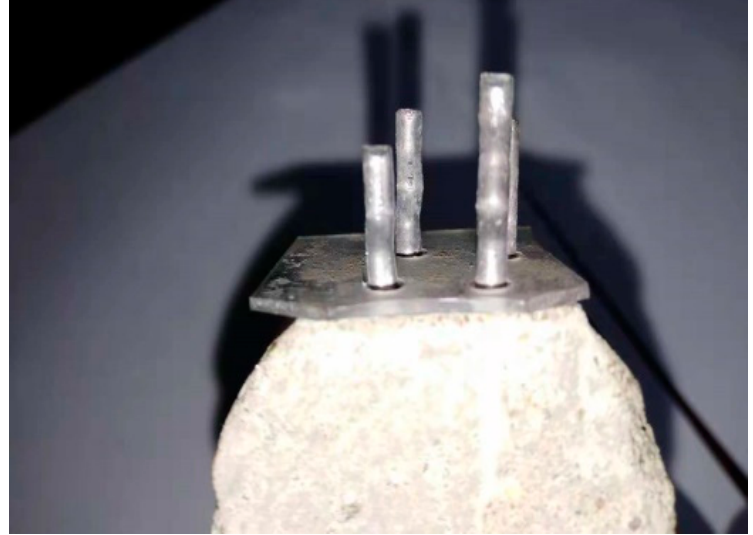
Figure 2. Pull-out test for the steel fiber from the cement matrix.